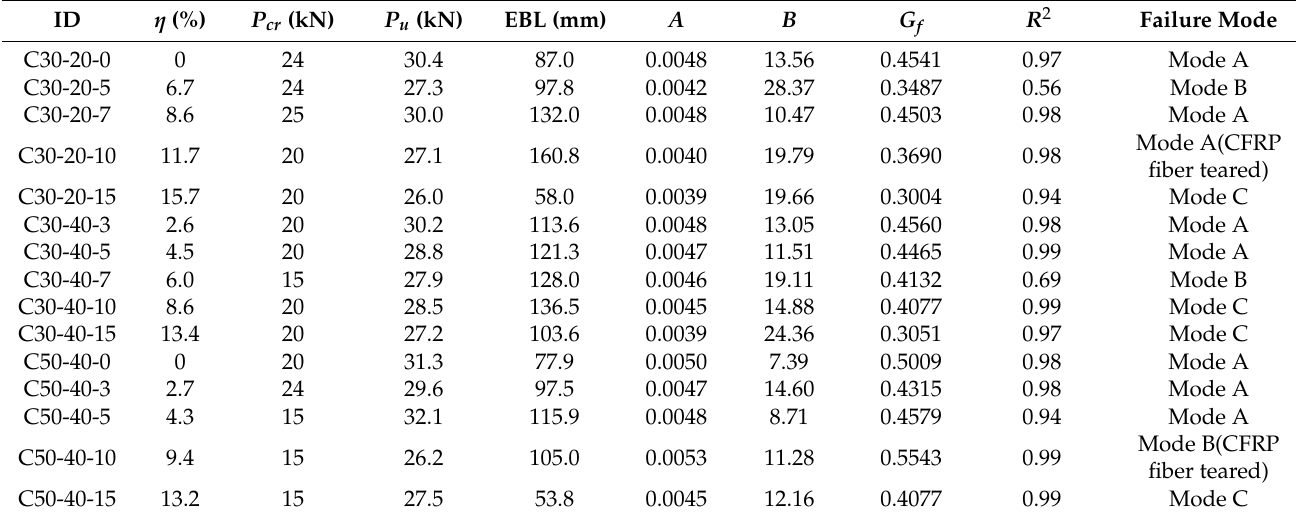
Table 3. Test results of double shear lap test.